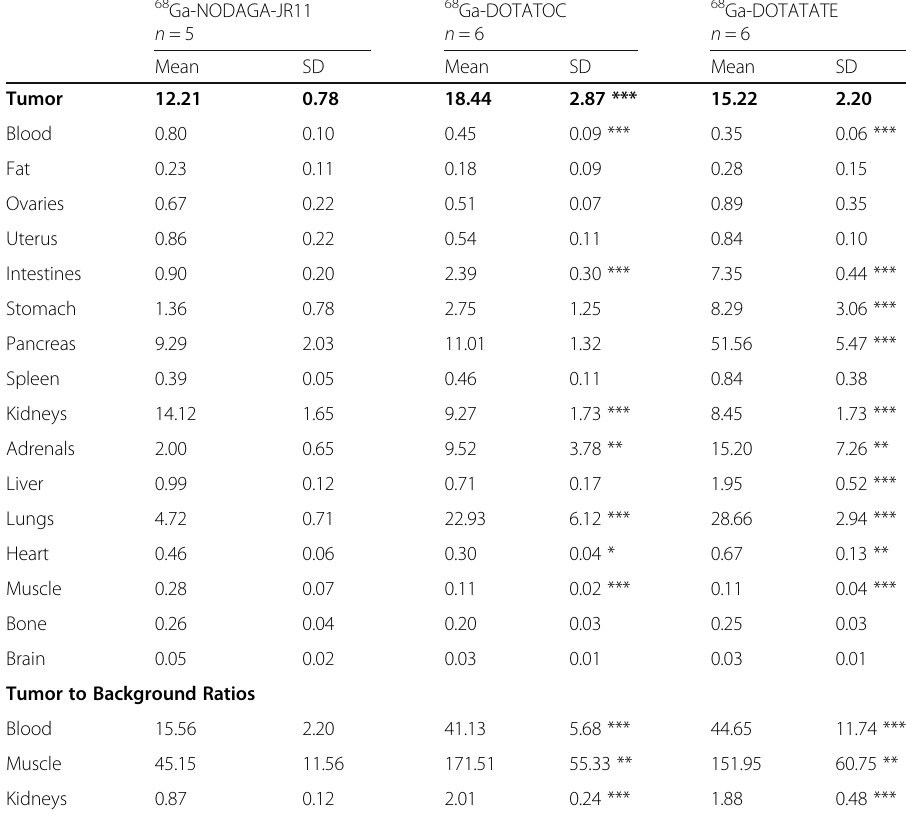
Table 3 Biodistibution of 68 Ga-NODAGA-JR11, 68 Ga-DOTATOC and 68 Ga-DOTATATE in NOD scid gamma ZR-75-1 tumor-bearing mice